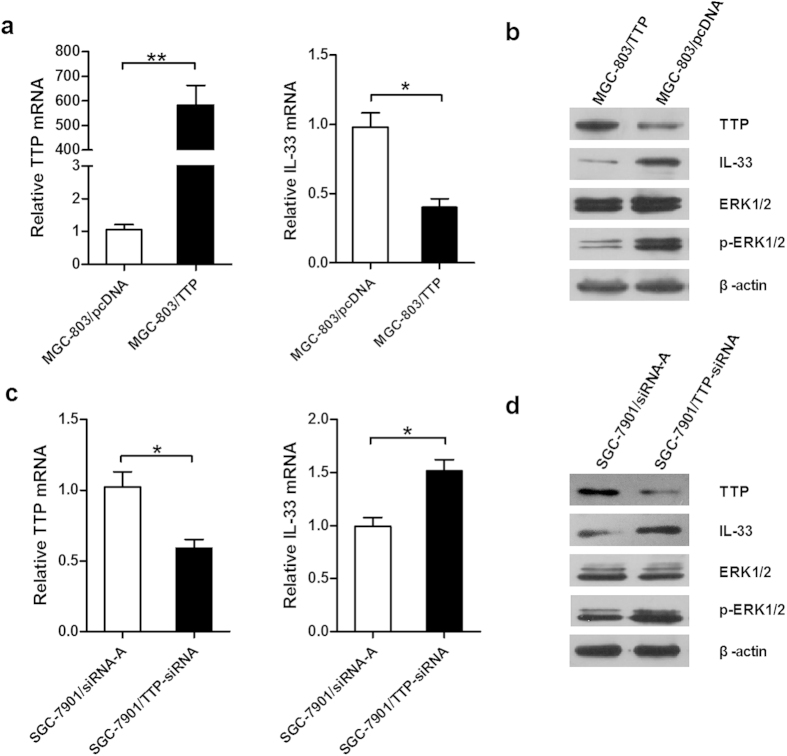
TTP regulates the expression of IL-33 and the activation of ERK1/2 in gastric cancer cells.(a,c) MGC-803 cells were transfected with pcDNA-TTP or empty vector pcDNA3.1(+); SGC-7901 cells were transfected with TTP-siRNA or control siRNA (siRNA-A). Expressions of TTP and IL-33 in cells were determined by qRT-PCR. (b,d) Expressions of TTP, IL-33, ERK1/2 and phosphorylation of ERK1/2 (p-ERK1/2) in transfected MGC-803 or SGC-7901 cells were examined by Western blotting. GAPDH and β-actin were used as internal controls for qRT-PCR and Western blotting analysis, respectively. All data are represented as the mean ± SD of three independent experiments. *P < 0.05, **P < 0.01.